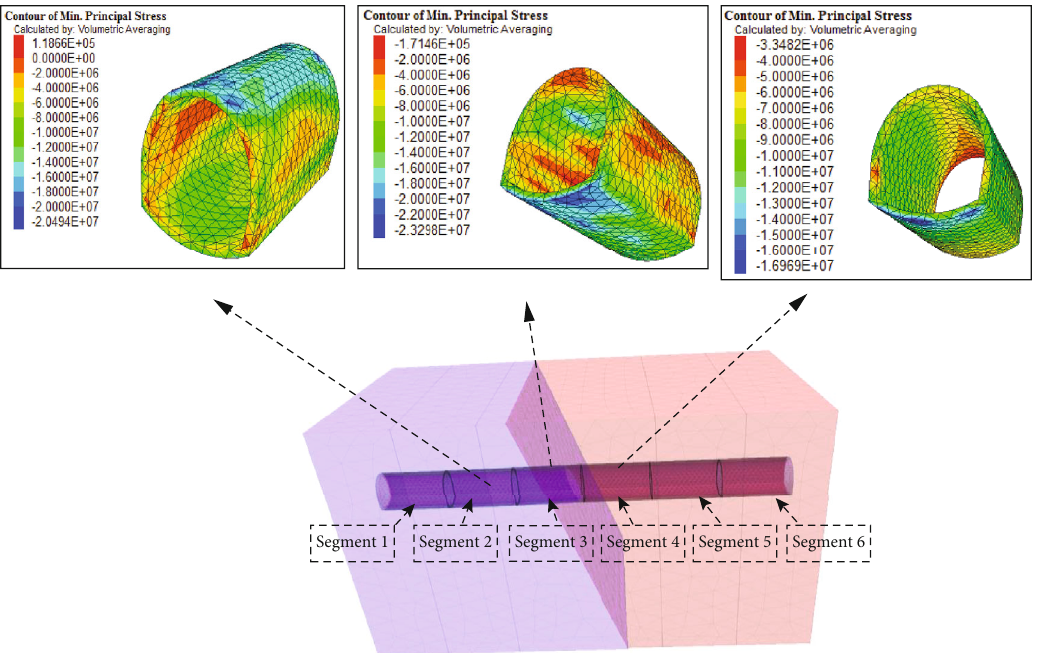
Figure 6: Minimum principal stress nephogram (units: